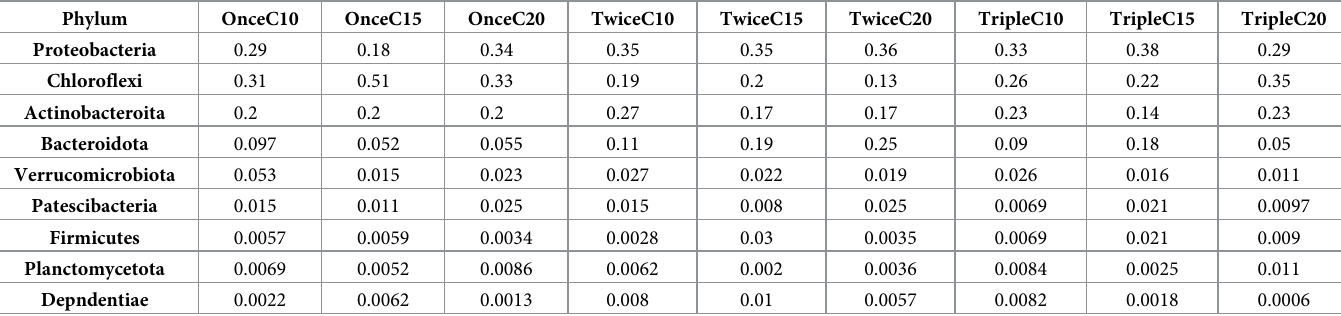
Table 5. Relative abundance of the most prevalent bacterial phyla identified in the intestine of Litopenaeus vannamei reared in biofloc.